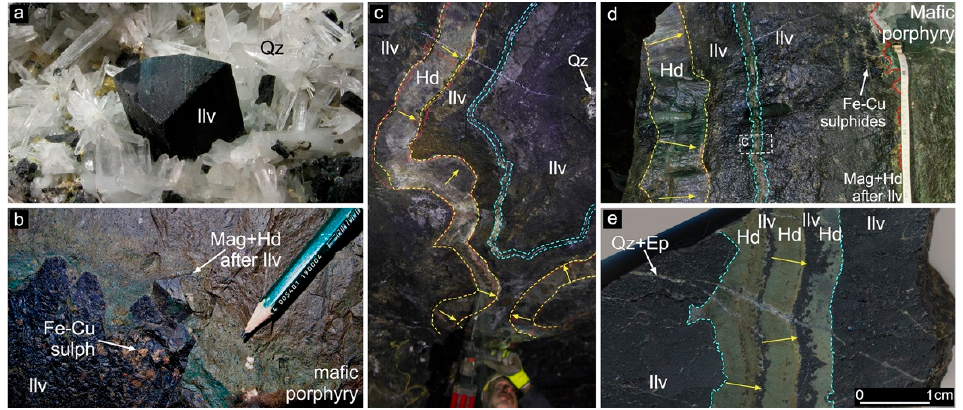
Figure 5. ( a ) Centimeter-size ilvaite crystal in skarn pocket associated with late quartz. ( b ) Euhedral ilvaite in a skarn pocket filled by mafic Temperino porphyry after ilvaite growth (level 3—Earle body). The first few centimeters of ilvaite are replaced by magnetite and hedenbergite. Additionally, Fe-Cu sulfides partially replace the ilvaite. ( c ) Banded ilvaite–hedenbergite skarn with centripetal sense of growth toward a pocket filled by late, low-temperature quartz (level 3—Earle body). ( d ) Same sequence of ( c ) with a pocket filled by mafic Temperino porphyry (level 3—Earle body). Fe-Cu sulfide veins and masses partially replacing primary skarn silicates. ( e ) Detail of the skarn sequence, with alternate millimetric bands of ilvaite and hedenbergite. Late quartz and epidote veins cutting the skarn. Yellow arrows indicate skarn mineral growth versors. See Figure 6 for location of images of skarn pockets ( c , d ).